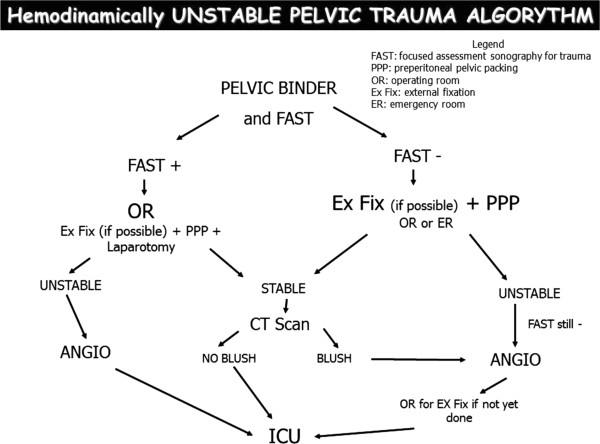
Treatment algorithm.